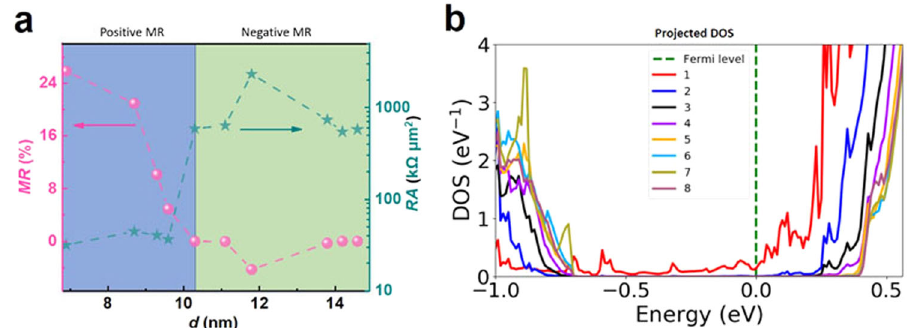
Fig. 5 Thicknesses-dependent MR and barrier height. a MR and resistance area as a function of different thicknesses of WSe 2 . b Barrier height between FGT and WSe 2 with different thicknesses.